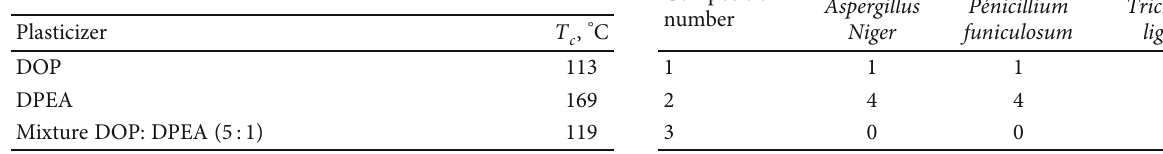
Table 4: The results of determining the critical temperature of the dissolution of plasticizers.